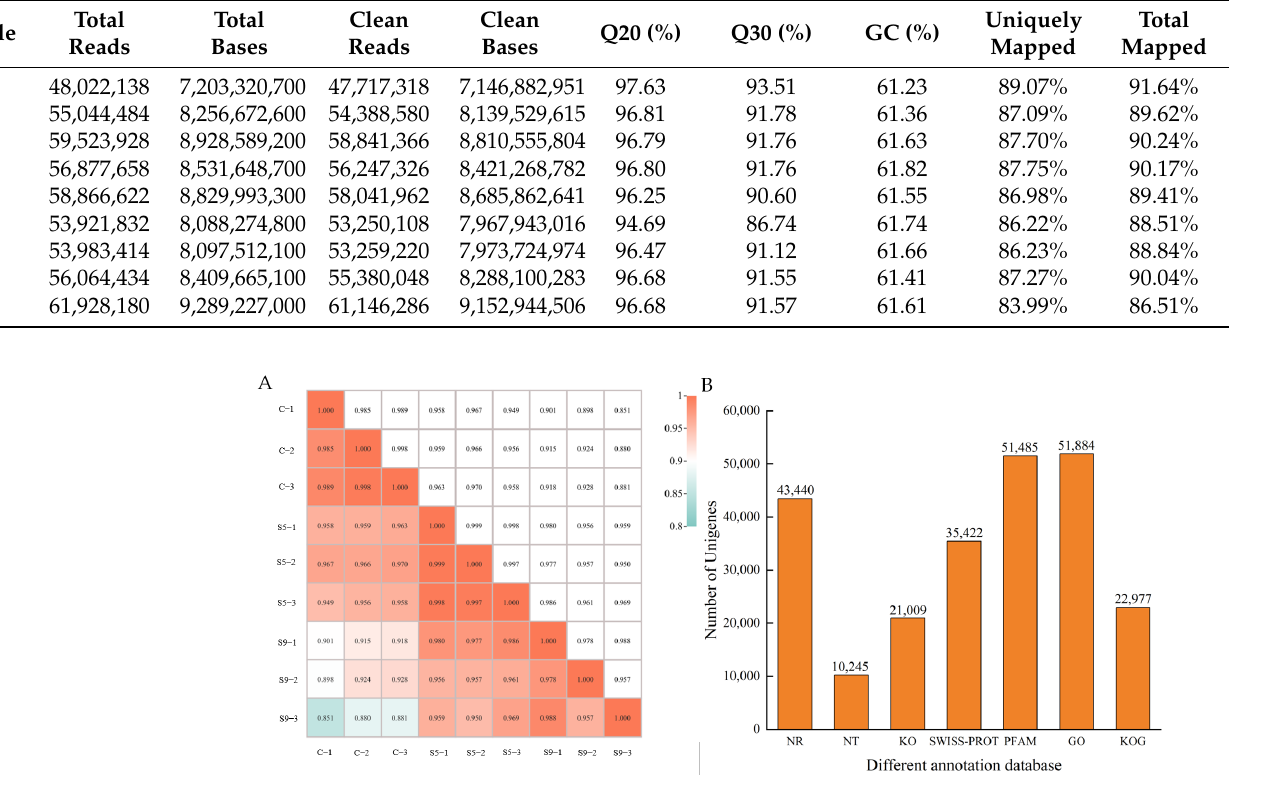
Figure 1. Pearson correlation coefficients for comparisons among all samples ( A ); number of unigenes functional annotation in different databases ( B ). (C: salinity 30 psu; S5: salinity 50 psu; S9: salinity 90 psu.)